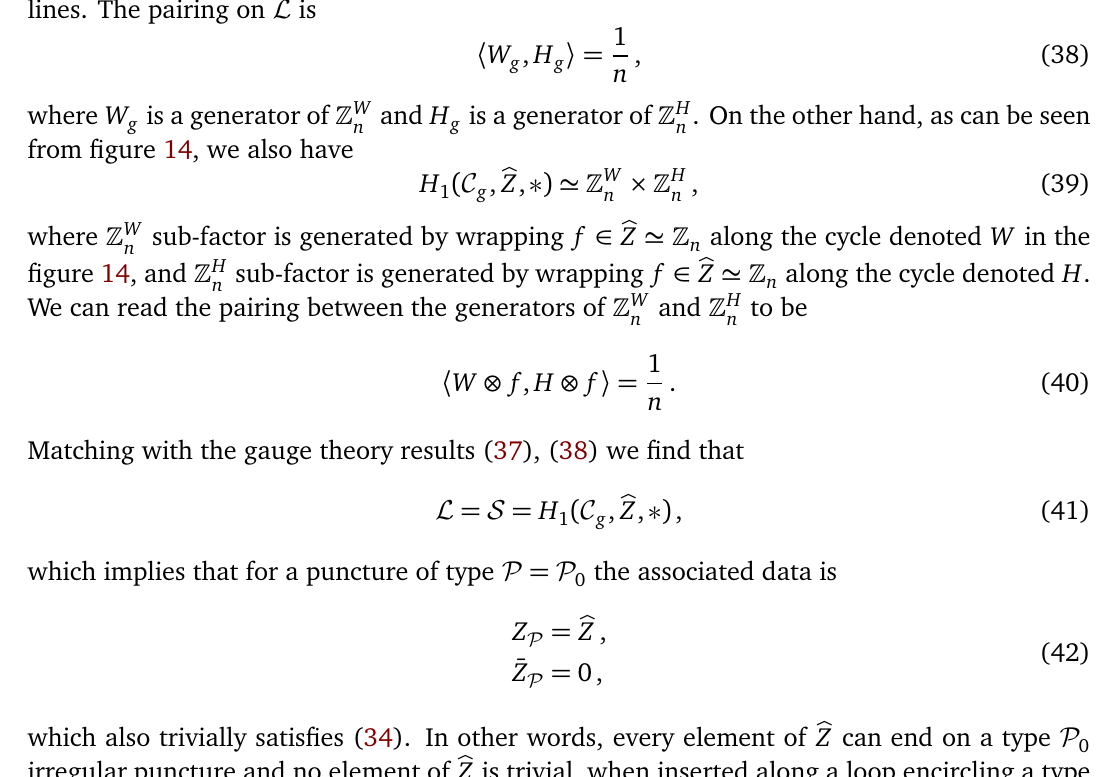
Figure 14: The generators W and H of 1-cycles on a 2-punctured sphere. The inter- section number between them is 〈 W , H 〉 =